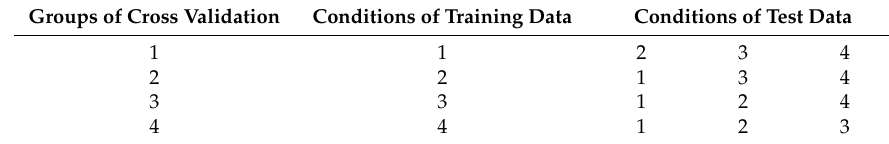
Table 3. The data composition of rolling bearing under variable conditions for cross validation.